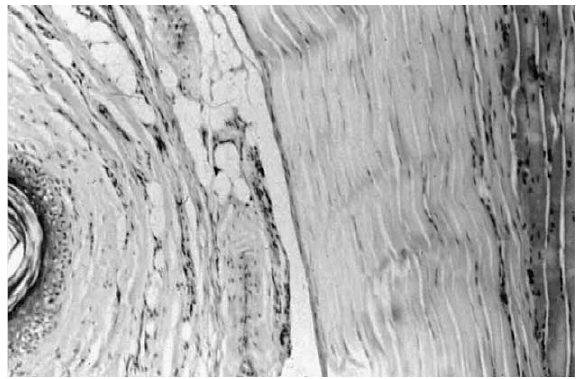
FIG. 2. Uninjured flexor tendon, synovial sheath and sub- cutaneous tissue in the rat ( (cid:4) / 10, haematoxylin and eosin). Tendon (right) and synovium (left) are separated by a clear synovial canal. The normal synovial and subsynovial tissues contain modest numbers of fibroblasts and inflammatory cells.